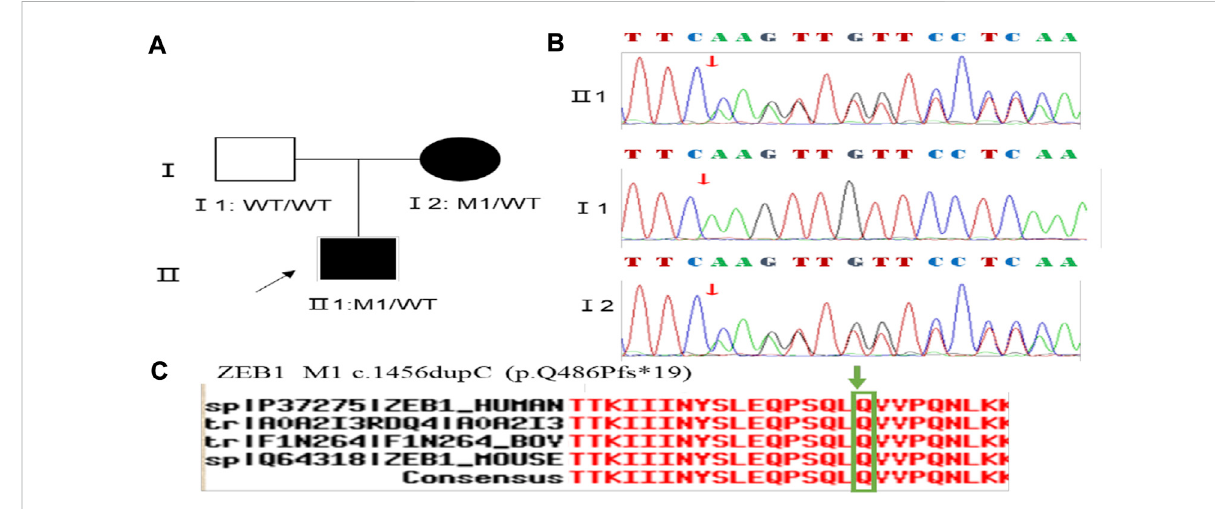
FIGURE 10 Sequence analysis and identi fi cation of the novel variant of ZEB1 in the affected Chinese family with autosomal-dominant KC. (A) Pedigree of thefamily.The fi lledblacksymbolsrepresenttheaffectedmembers,andthearrowdenotestheproband. (B) Bysequencinganalysis,aheterozygous variantof (C) 1456dupCwasidenti fi edintheaffectedindividualsofII:1andI:1. (C) ThehomologyofaminoacidsequencesbetweenhumanZEB1and other species. The amino acid at position 486 (Glutamine, Q486) is highly conserved among species (green